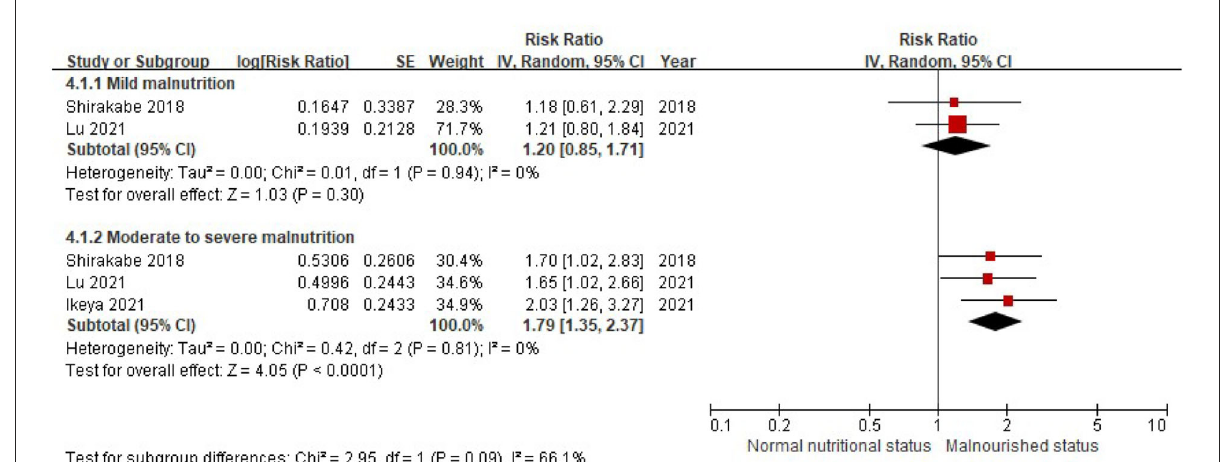
FIGURE4 A forest plot of comparison: All-cause mortality in patients with HF associated with different levels of malnourished status defined by the CONUT score. CONUT, controlling nutritional status; HF, heart failure.